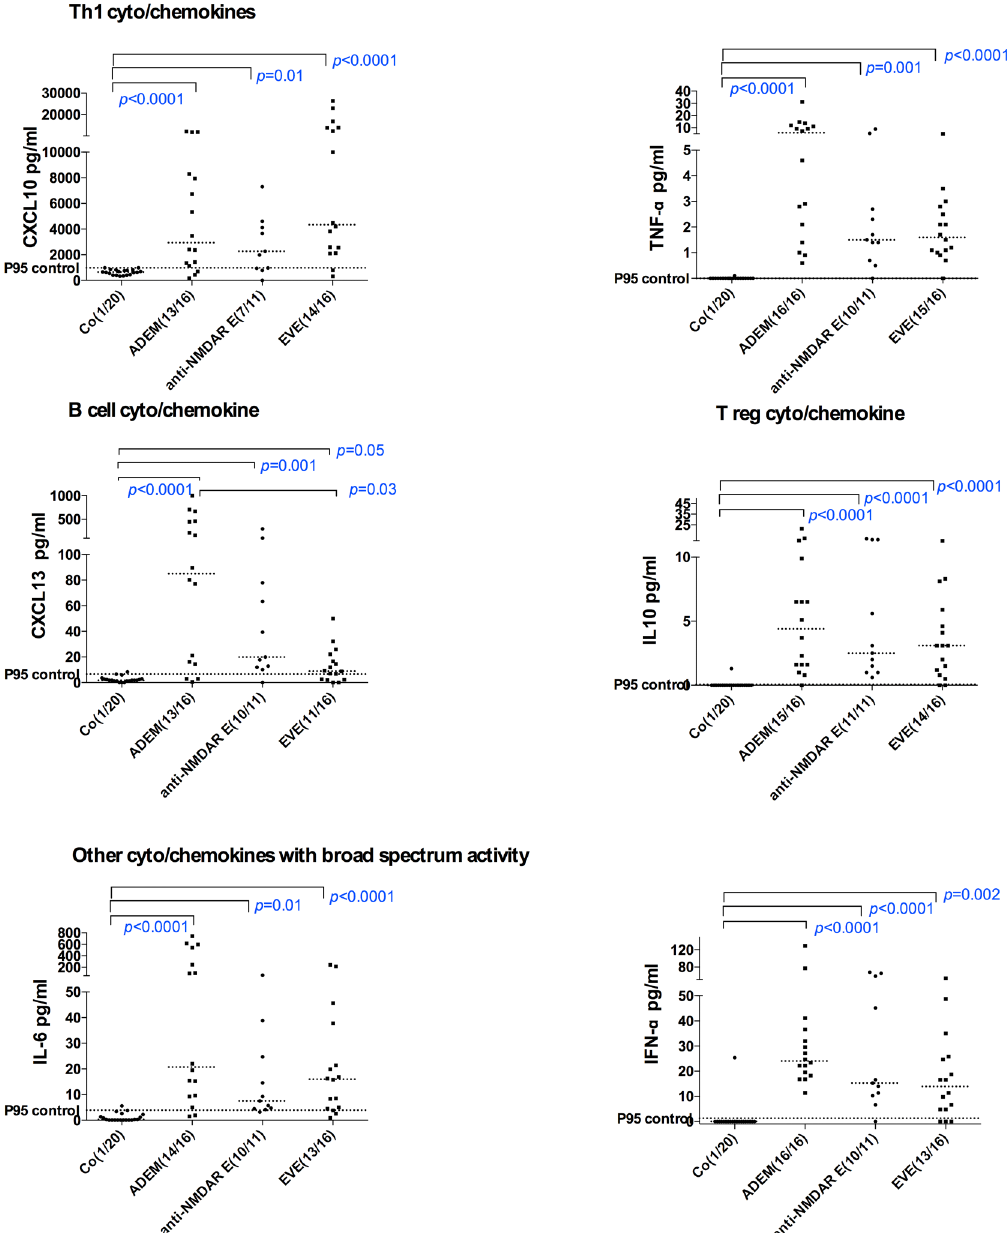
Fig 1. CSF concentrations of cytokine/chemokines with > 75% sensitivity to detect intrathecal inflammation in all children with acute encephalitis- acute disseminated encephalomyelitis (ADEM), anti-NMDAR encephalitis (anti-NMDAR E) and enteroviral encephalitis (EVE). Dotted lines represent medians. The statistical analysis was performed using Kruskal Wallis test. The 95% centile of the control values are presented (P95 control).